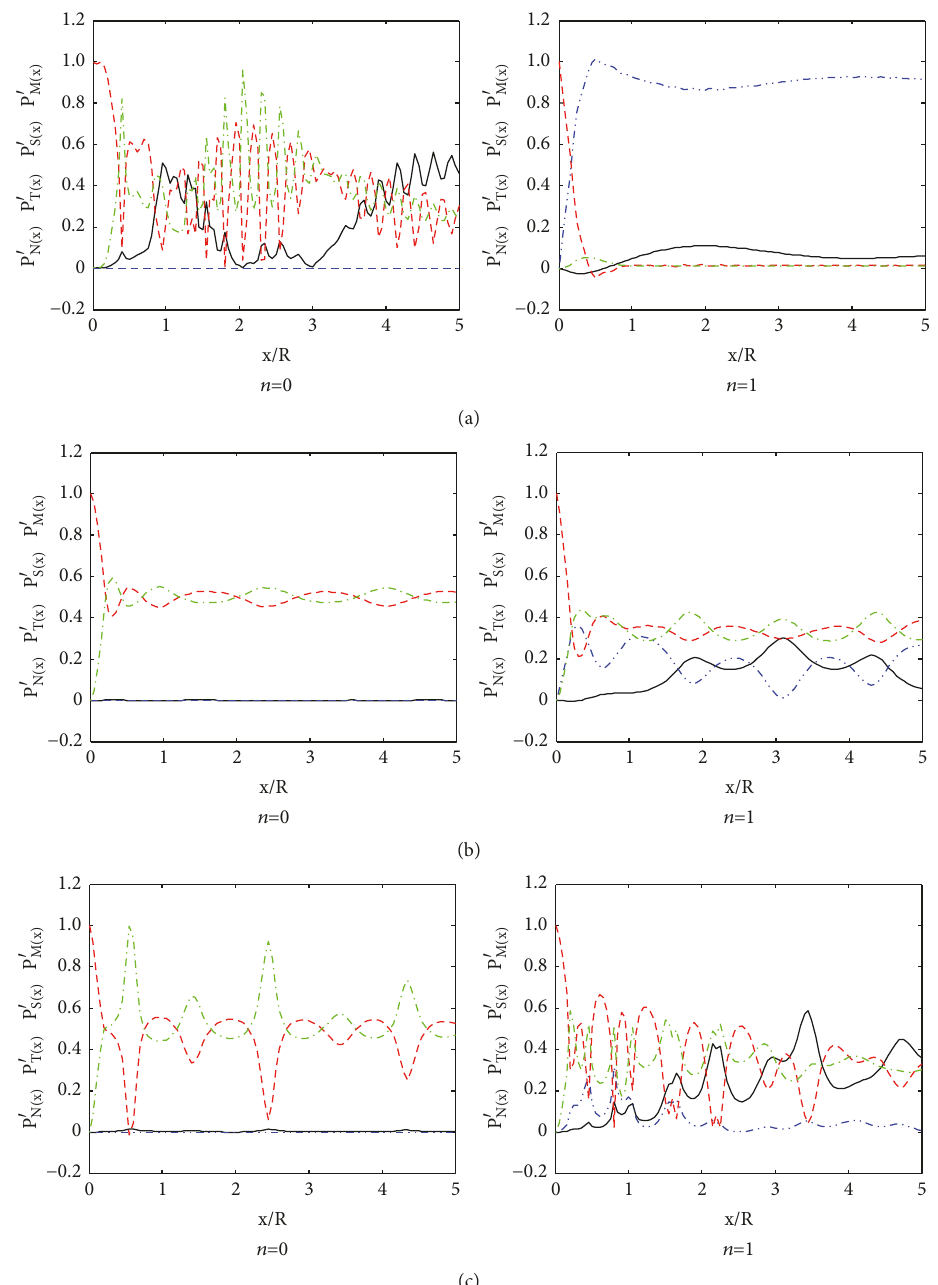
Figure 12: Power transmitted by different shell forces (moments) with ℎ/𝑅 = 0.075 : (a) Ω = 0.3 , (b) Ω = 1.2 , and (c) Ω = 3.0 ; black solid line: 𝑃 󸀠 𝑆(𝑥) ; blue dashed double dotted line: 𝑃 󸀠 𝑇(𝑥) ; red dashed line: 𝑃 󸀠 𝑆(𝑥) ; green dashed dotted line: 𝑃 󸀠 𝑀(𝑥)